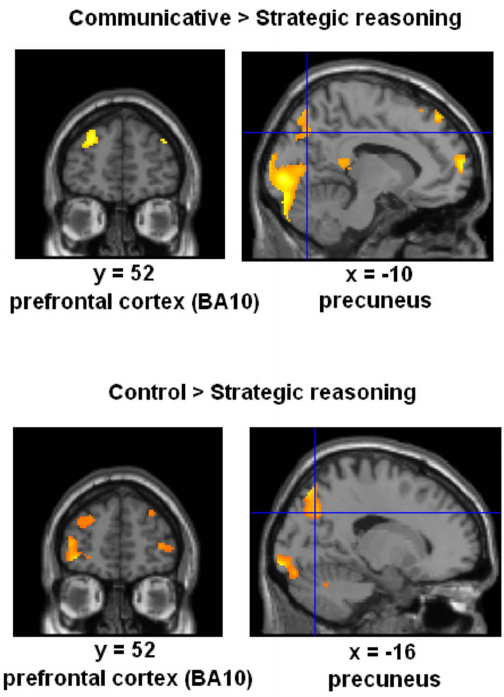
Figure 1. Statistical map showing brain activations for the contrasts communicative relative to strategic reasoning and control relative to strategic reasoning (random-effects analy- sis, FDR corrected). Results demonstrate increased activations for communicative reasoning (with respect to strategic rationality) including prefrontal cortex (BA10) and precuneus. Strategic reasoning revealed less activation for prefrontal cortex (BA10) and precuneus compared with a control task. Areas of significant fMRI signal change are shown as color overlays on the T1-MNI reference brain. See text and Table 1 for details.